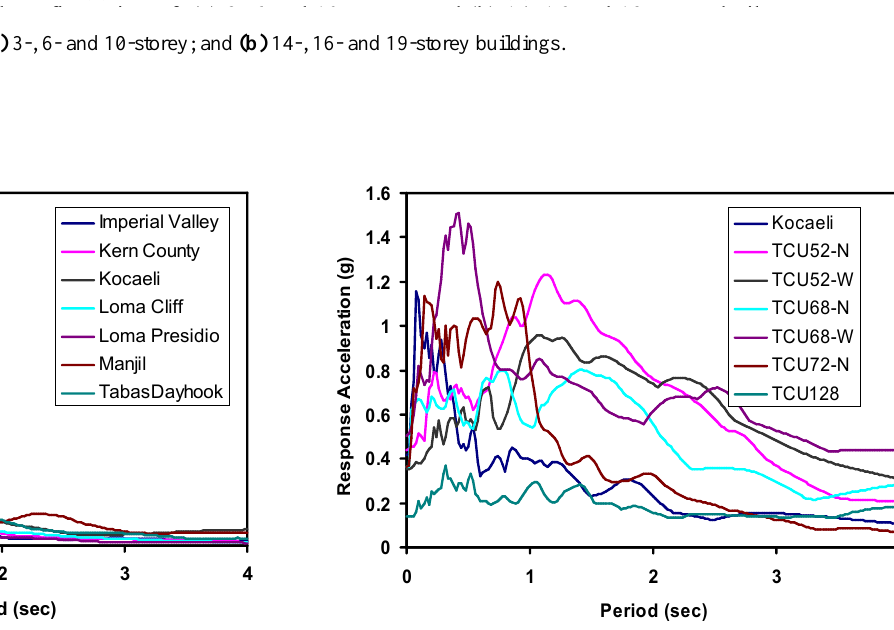
Peak displacement profiles for the 3-storey building with (a) V/W=cte, (b) U top /H=cte